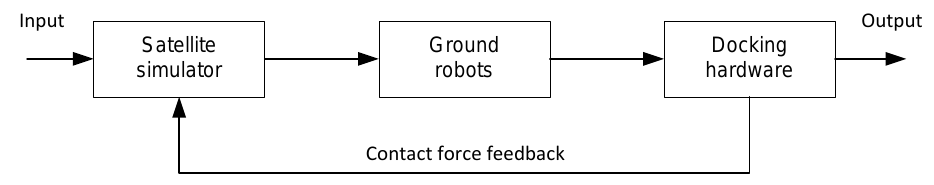
Figure 22: Force/Torque Feedback Loop of a Contact Dynamics